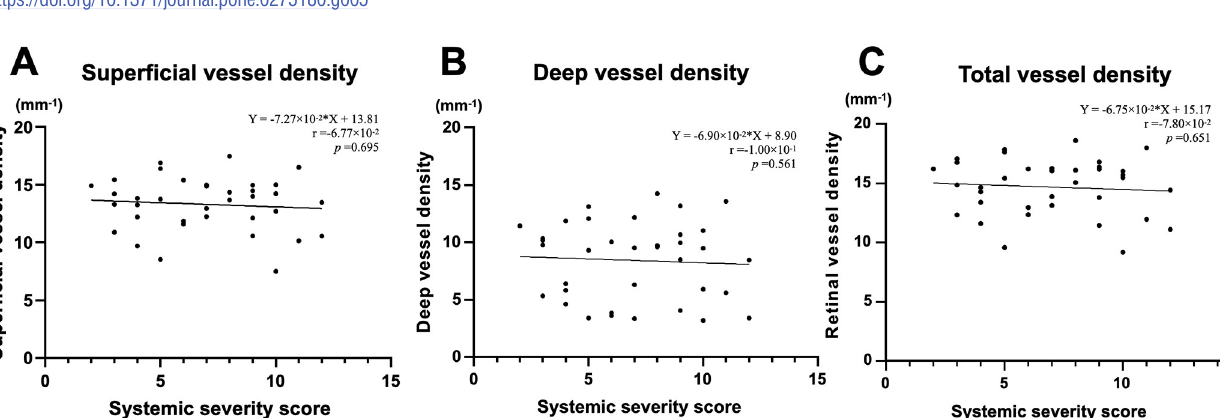
Fig 6. Spearman’s rank correlation analysis showed no significant correlations between the vessel density in various slabs ((A) superficial slab; (B) deep slab; (C) total retinal slab) and the systemic severity score. https://doi.org/10.1371/journal.pone.0275180.g006 PLOS ONE | https://doi.org/10.1371/journal.pone.0275180 September 26,